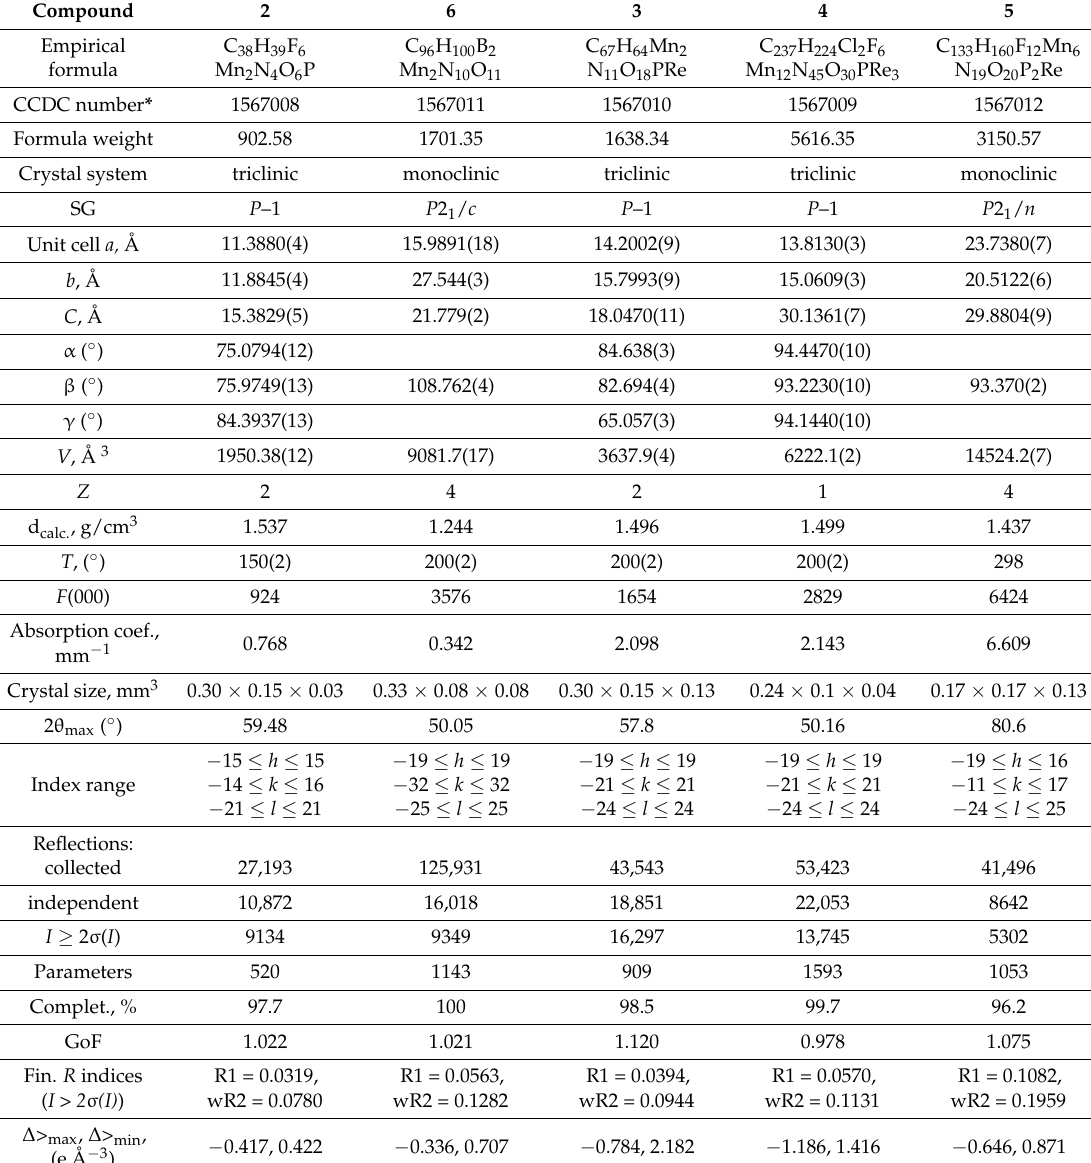
Table 1. Crystallographic data for compounds 2 – 6